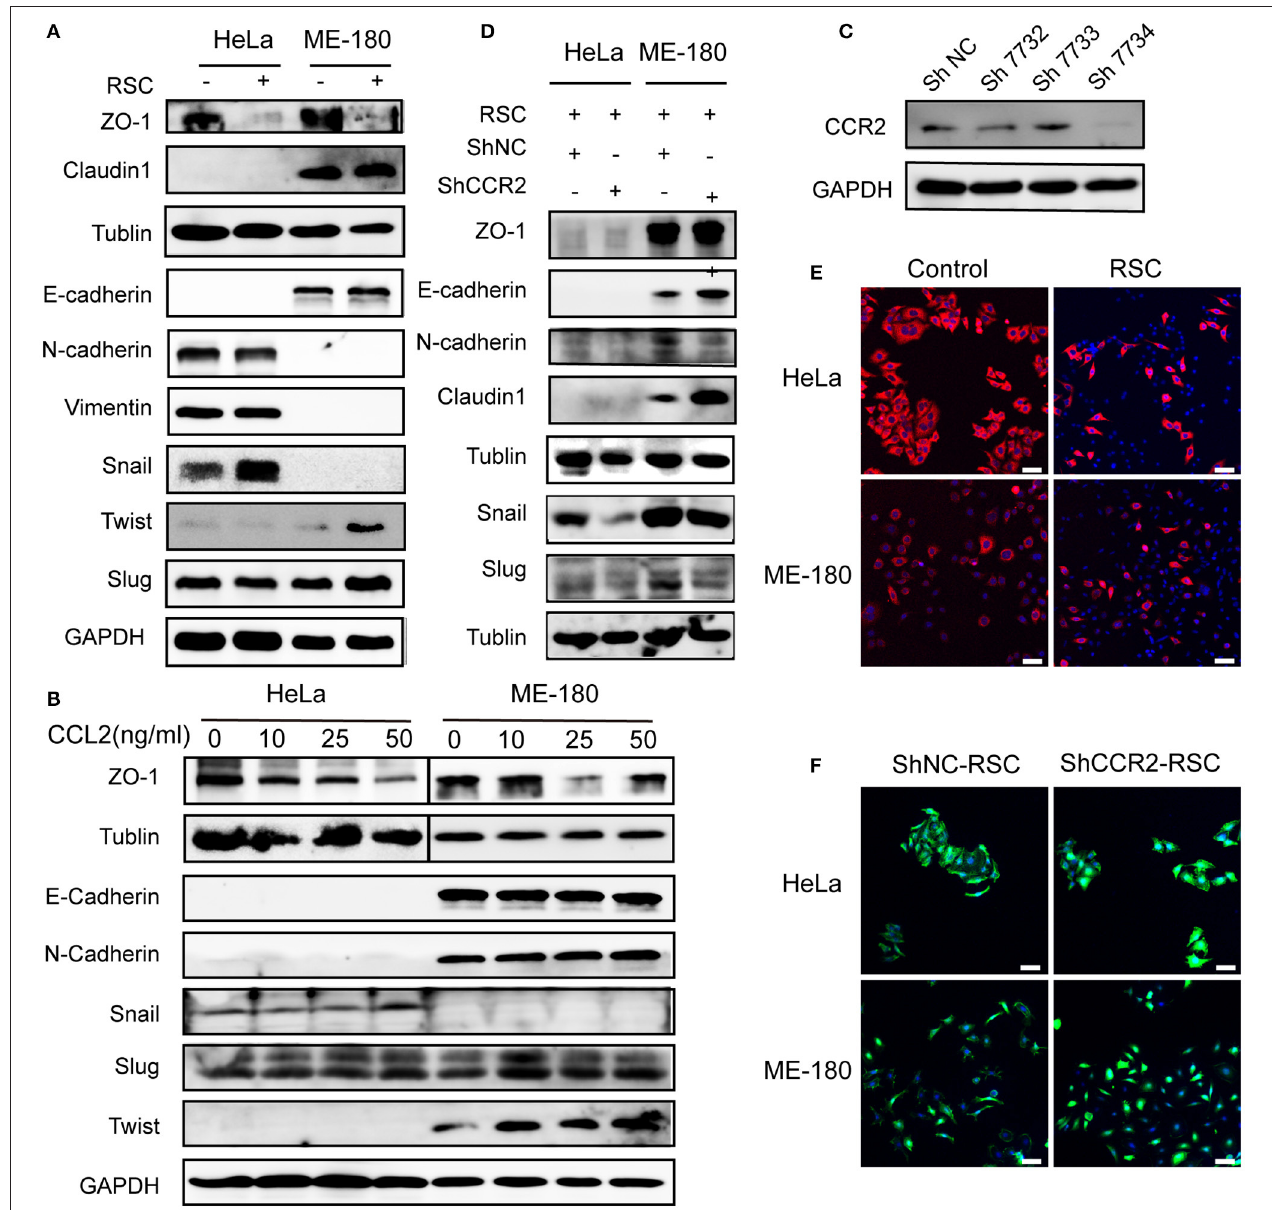
FIGURE 5 | Effect of CCL2 on EMT of human cervical cancer cells. (A) Markers of EMT were altered in HeLa and ME-180 cells after cocultivation with SCs. GAPDH or β -tublin were used as internal loading controls. (B) Hela and ME-180 cells were exposed to different concentrations of CCL2 followed by protein isolation, to assess EMT markers via western blot. (C) Expression of CCR2 was measured in HeLa cells after transfection with a panel of shRNAs targeting CCR2 or control shRNA. The sh7734 was used to create stably silenced shCCR2 cells. (D) Western blot analyses of the EMT related markers after silencing CCR2 in HeLa and ME-180 cells. (E) SCs brought about morphological changes ranging from an epithelial plasticity toward a fibroblast-like phenotype (stained with pan-CK) (100 × magnification, scale bar, 100 µ m). (F) Downregulation of CCR2 in HeLa and ME-180 cells showed opposing changes through FITC-phalloidin staining compared with the control group (100 × magnification, scale bar, 100 µ